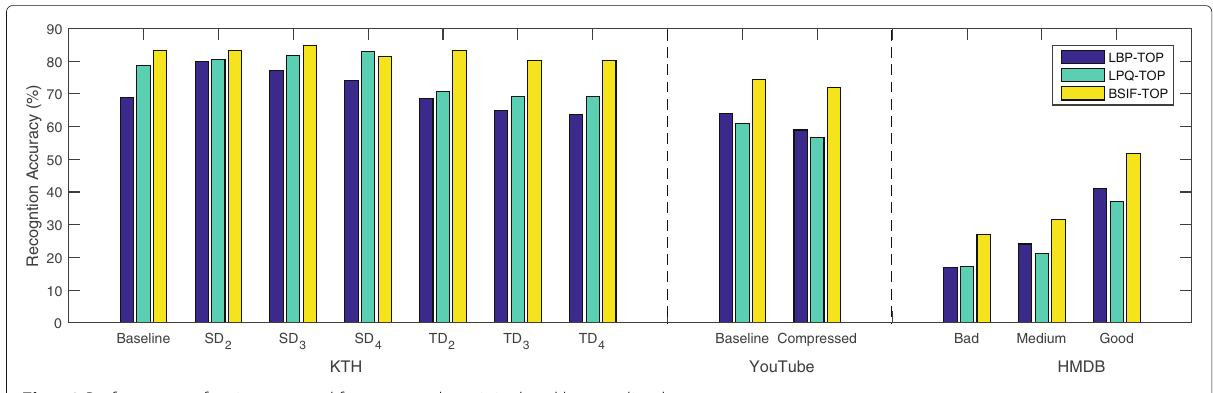
Fig. 12 Performance of various textural features on the original and low quality datasets